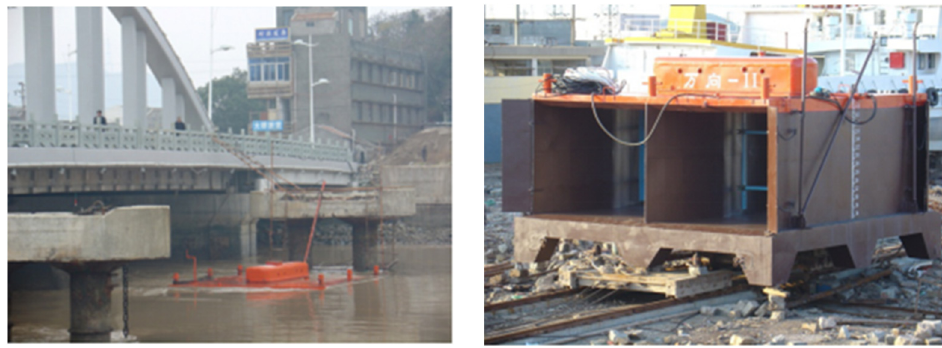
Figure 4. “Wanxiang II”—the first submarine vertical-axis TCPGS. Reproduced from [21], Elsevier. “Haiming I” (10 kW) is the first submarine vertical-axis TCPGS for long-term demon- stration operation in China (see in Figure 5). The power station (size: 9.0 m × 7.5 m × 6.5 m, weight: 20 T) adopts a horizontal-axis fixed-pitch turbine, an efficient expansion-type de- flector and a direct-drive permanent magnet synchronous generator (PMSG). This device is supported by a three-legged base frame that can be lifted for maintenance